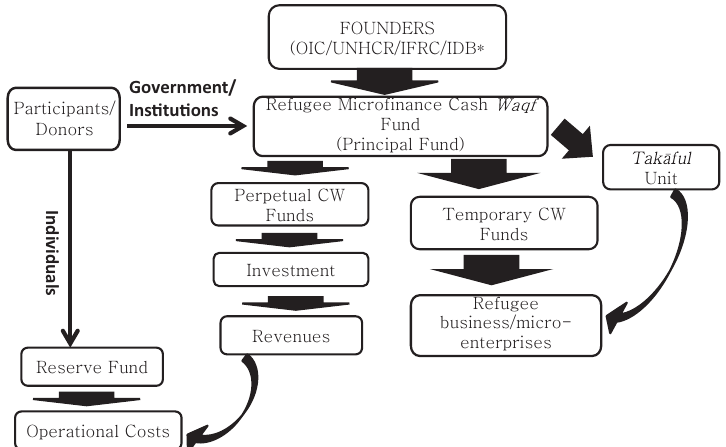
Figure 1. Cash waqf